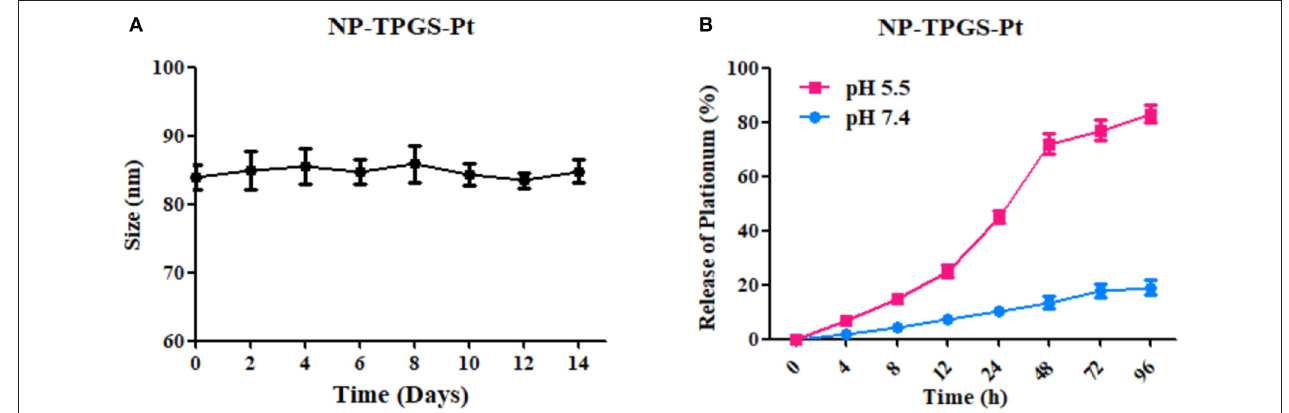
FIGURE 6 | Cellular uptake of NP-TPGS-Pt by A549 andA549/DDP cells. (A,B) CLSM images in A549 and A549/DDP cells, (C) Cellular uptake efficiency of A549 and A549/DDP cells after incubation with NP-PEG-Pt and NP-TPGS-Pt for 3h. (D) An illustration for cell uptake in A549/DDP cells. (Scale bar: 20 µ m).